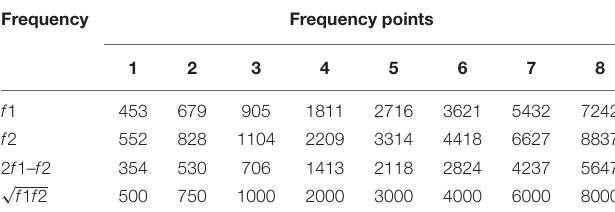
TABLE 1 | Results at eight frequency points with DPOAE